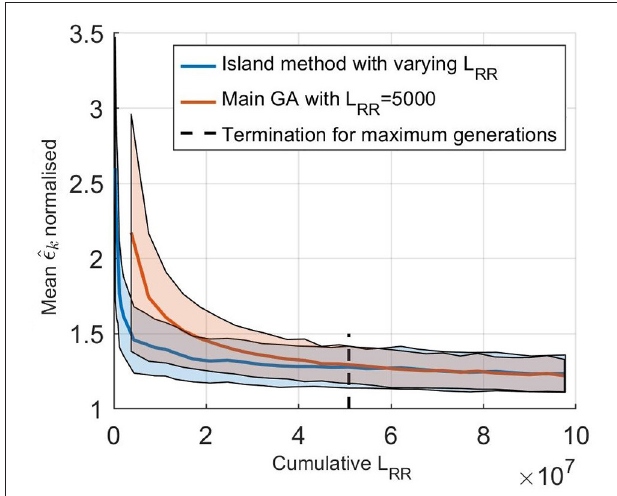
ǫ k of 100 optimizations of the five set FIGURE 5 | (solid line) Mean normalized ˆ of patient data as a function of cumulative L RR for (blue) the island start optimization with varying L RR and (orange) only the main GA with a fix L RR at ǫ k is 5,000. The shaded background represents one standard deviation. Here, ˆ normalized with the best ǫ found for each patient, to account for the fact that the model can not fit each RR interval series equally